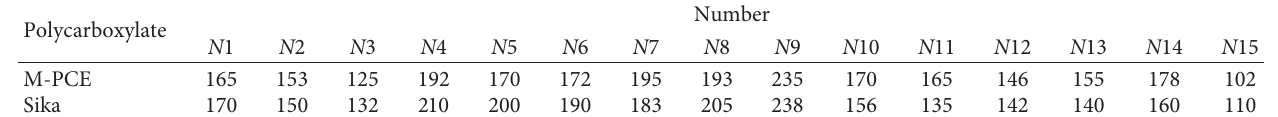
Table 4: Initial flowability of UHPC with different compositions (mm).